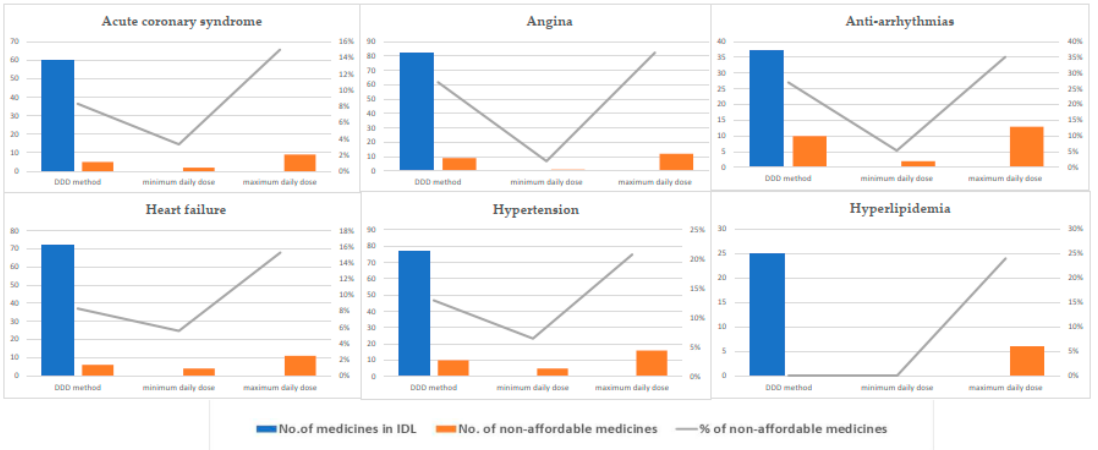
Figure 1. The affordability of medicines in cardiovascular disease (CVD) therapeutic groups based on monotherapy treatment scenarios.